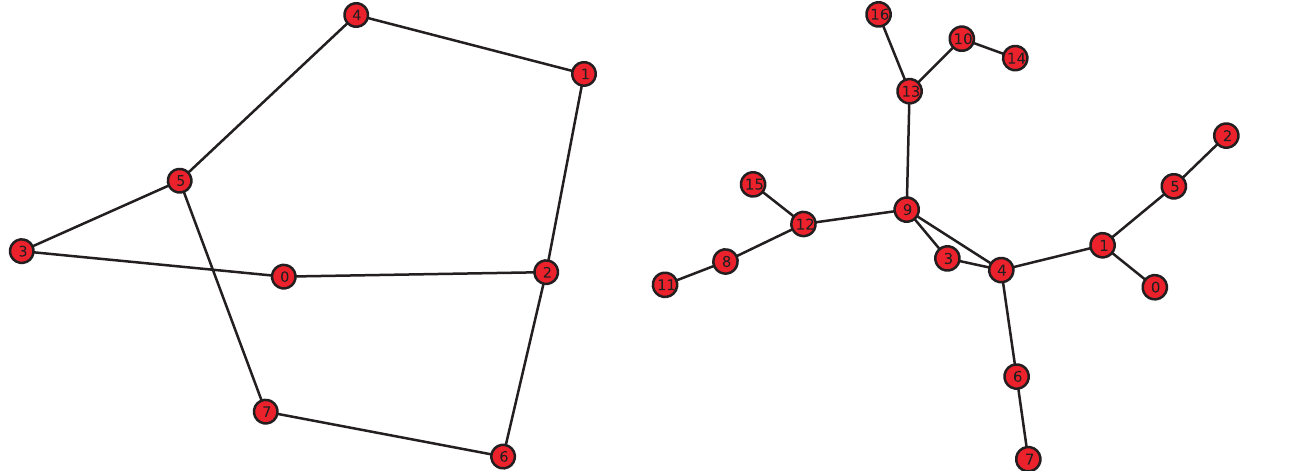
Figure 3. Example Graph with relatively small value of both I orb and I l . (reference label: graph_plot1). f V exp